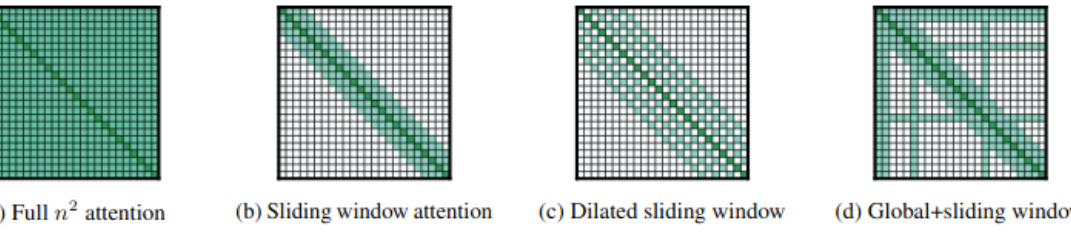
Figure 7. Different attention schemes [25]. Longformer attention scheme is presented by ( d